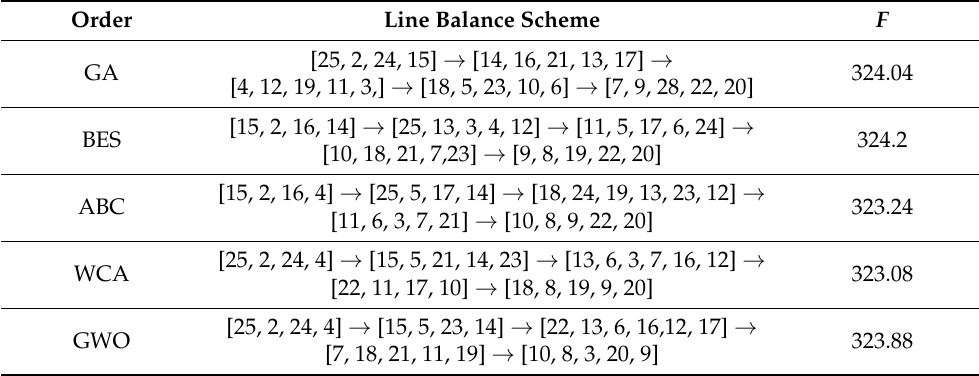
Figure 17. Convergence curves for the five algorithms. Table 3. Five algorithms for disassembly sequences.